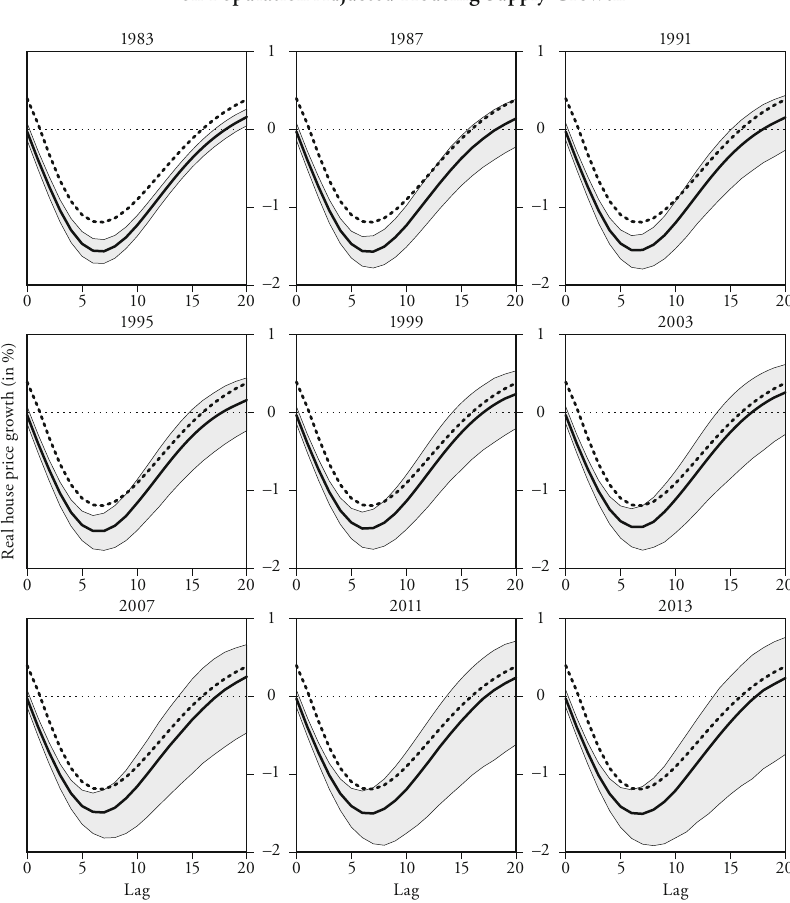
Figure 5: Response of House Prices to a Shock on Population Adjusted Housing Supply